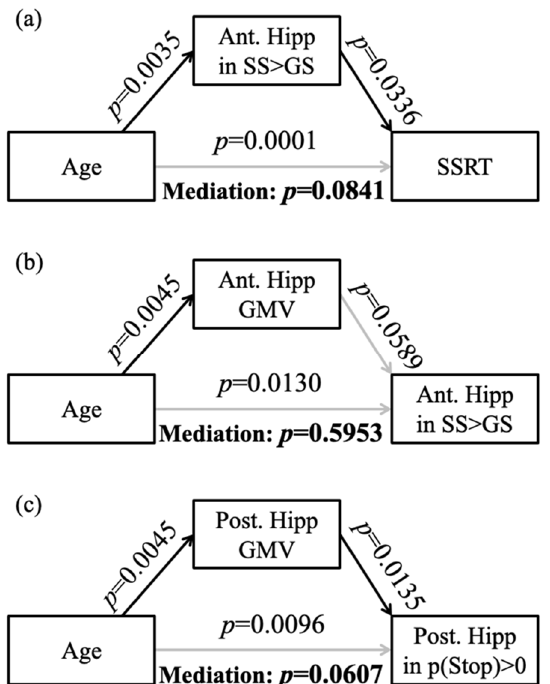
Figure 3. Mediation analysis between ( a ) age and SSRT with the right anterior hippocampal activation to SS > GS being the mediator, ( b ) age and the right anterior hippocampal activation to SS > GS with the GMV of right anterior hippocampus being the mediator, and ( c ) age and the right posterior hippocampal activation to p(Stop) with GMV of right posterior hippocampus being the mediator. Ant. Hipp: anterior hippocampus; Post. Hipp: posterior hippocampus; gray line: not significant result.